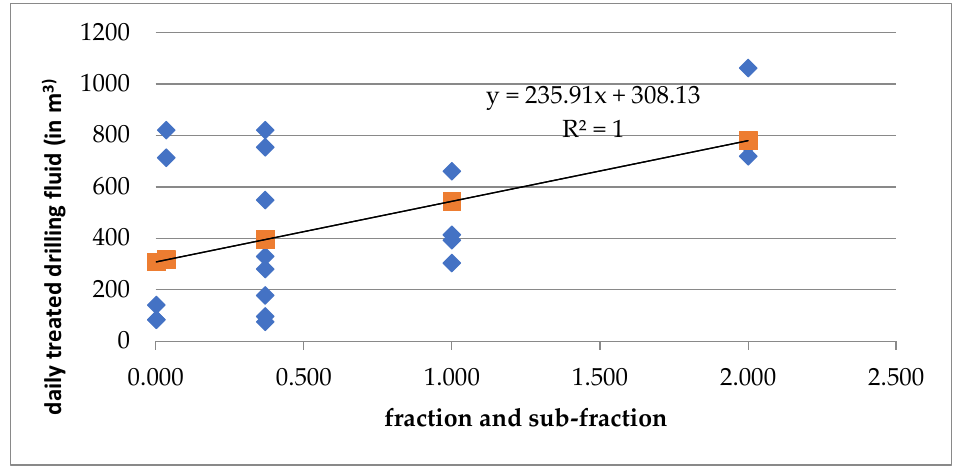
Figure 11. Correlation between the percentages of drilling fluid treated daily (in m 3) and the type of soil fraction in th e Pęciszów facility.